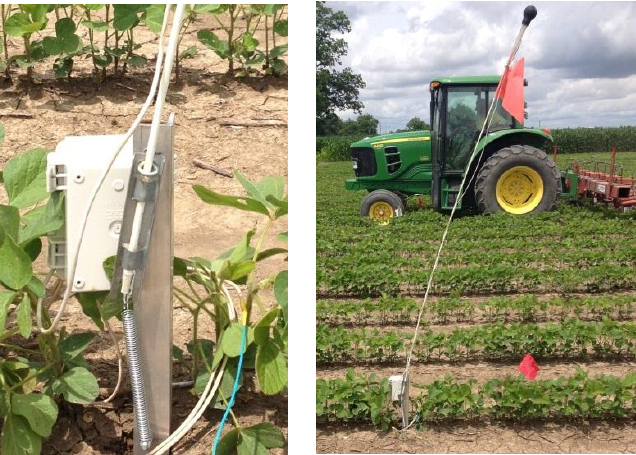
Figure 2. Close-up ( Left ) and complete view ( Right ) of field datalogger and radio/antenna mount installed in a soybean